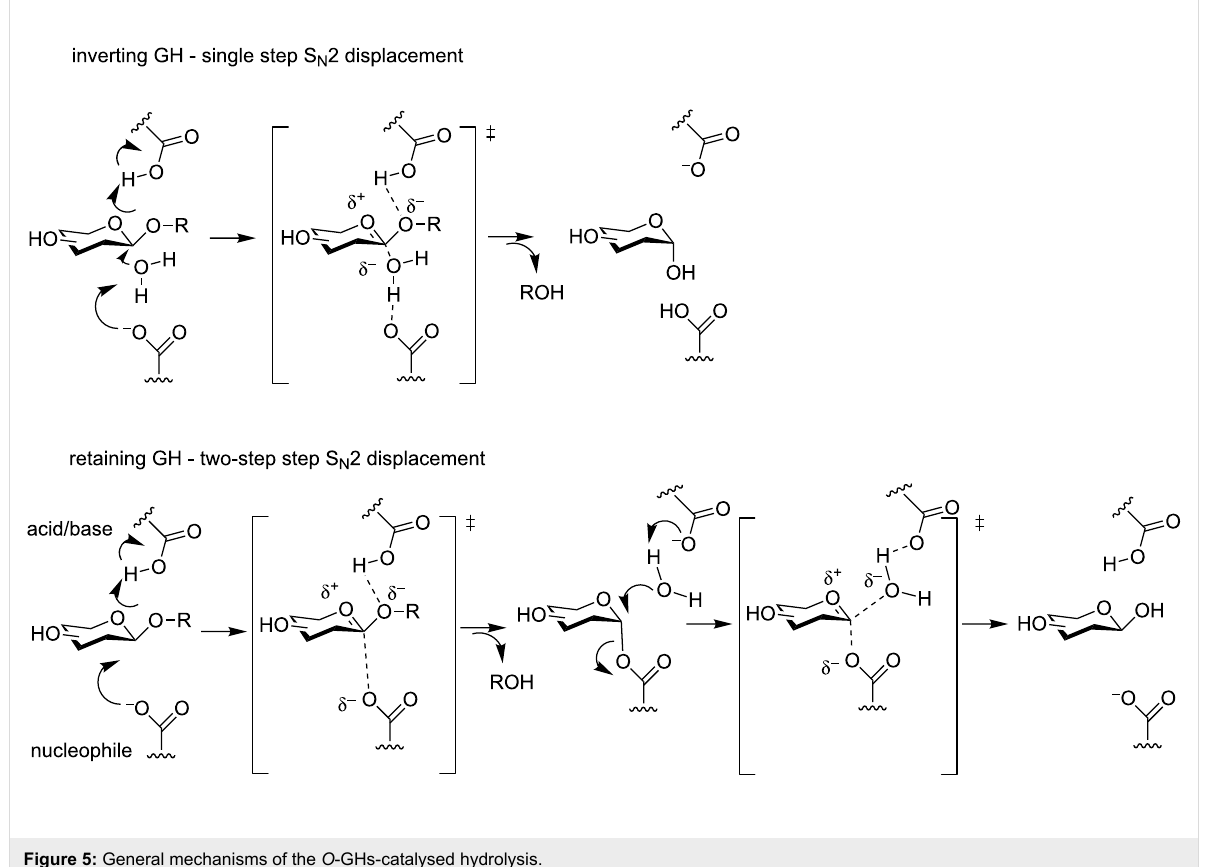
Figure 5: General mechanisms of the O -GHs-catalysed